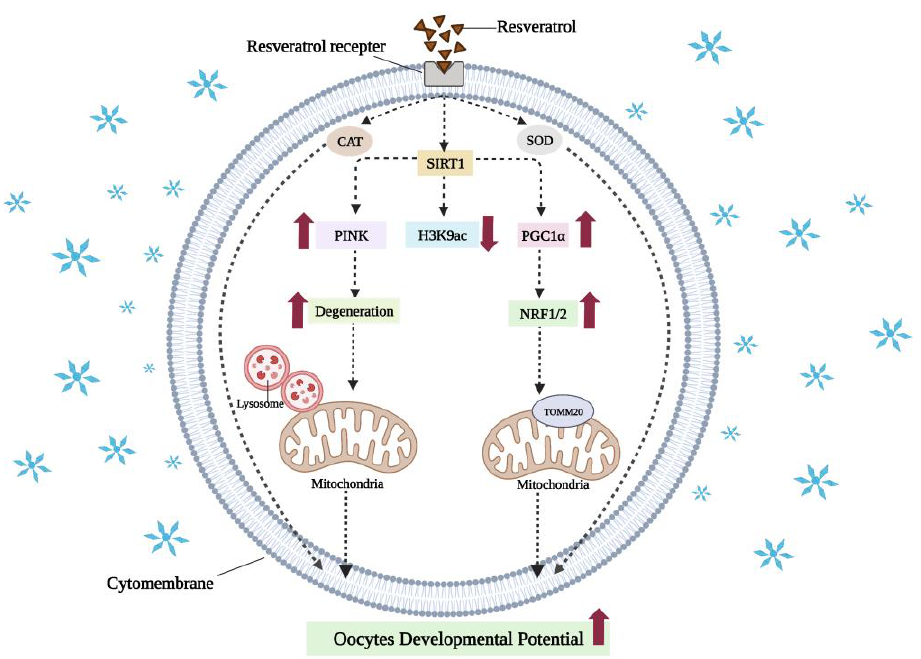
Figure 5. The mechanism of resveratrol in reducing oxidative damages of vitrified oocytes. Resvera- trol can enter oocytes through receptors, activate the activity of antioxidant enzymes, and reduce oxidative stress caused by cryopreservation. It can also activate SIRT1 via receptors to deacetylate PGC1α, and activate NRF1 and NRF2 to enhance mitochondrial biosynthesis. Epigenetically, resveratrol can also reduce abnormal H3K9 acetylation levels via SIRT1. In addition, resveratrol can promote the degradation of damaged mitochondria, maintain the quality of mitochondria, and restore the developmental potential of oocytes. ↑ and ↓ , indicate a significant increase or decrease, respectively. Created with BioRender.com (accessed on 19 October, 2022).